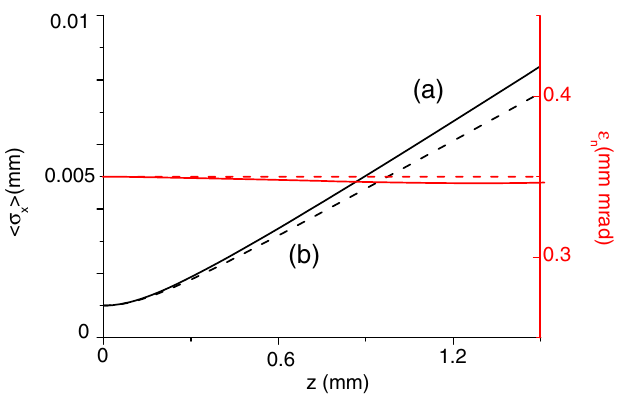
i and transverse normalized emit- x (cid:1) z (cid:6) 0 (cid:2) (cid:6) 0 : 3 mm mrad , n